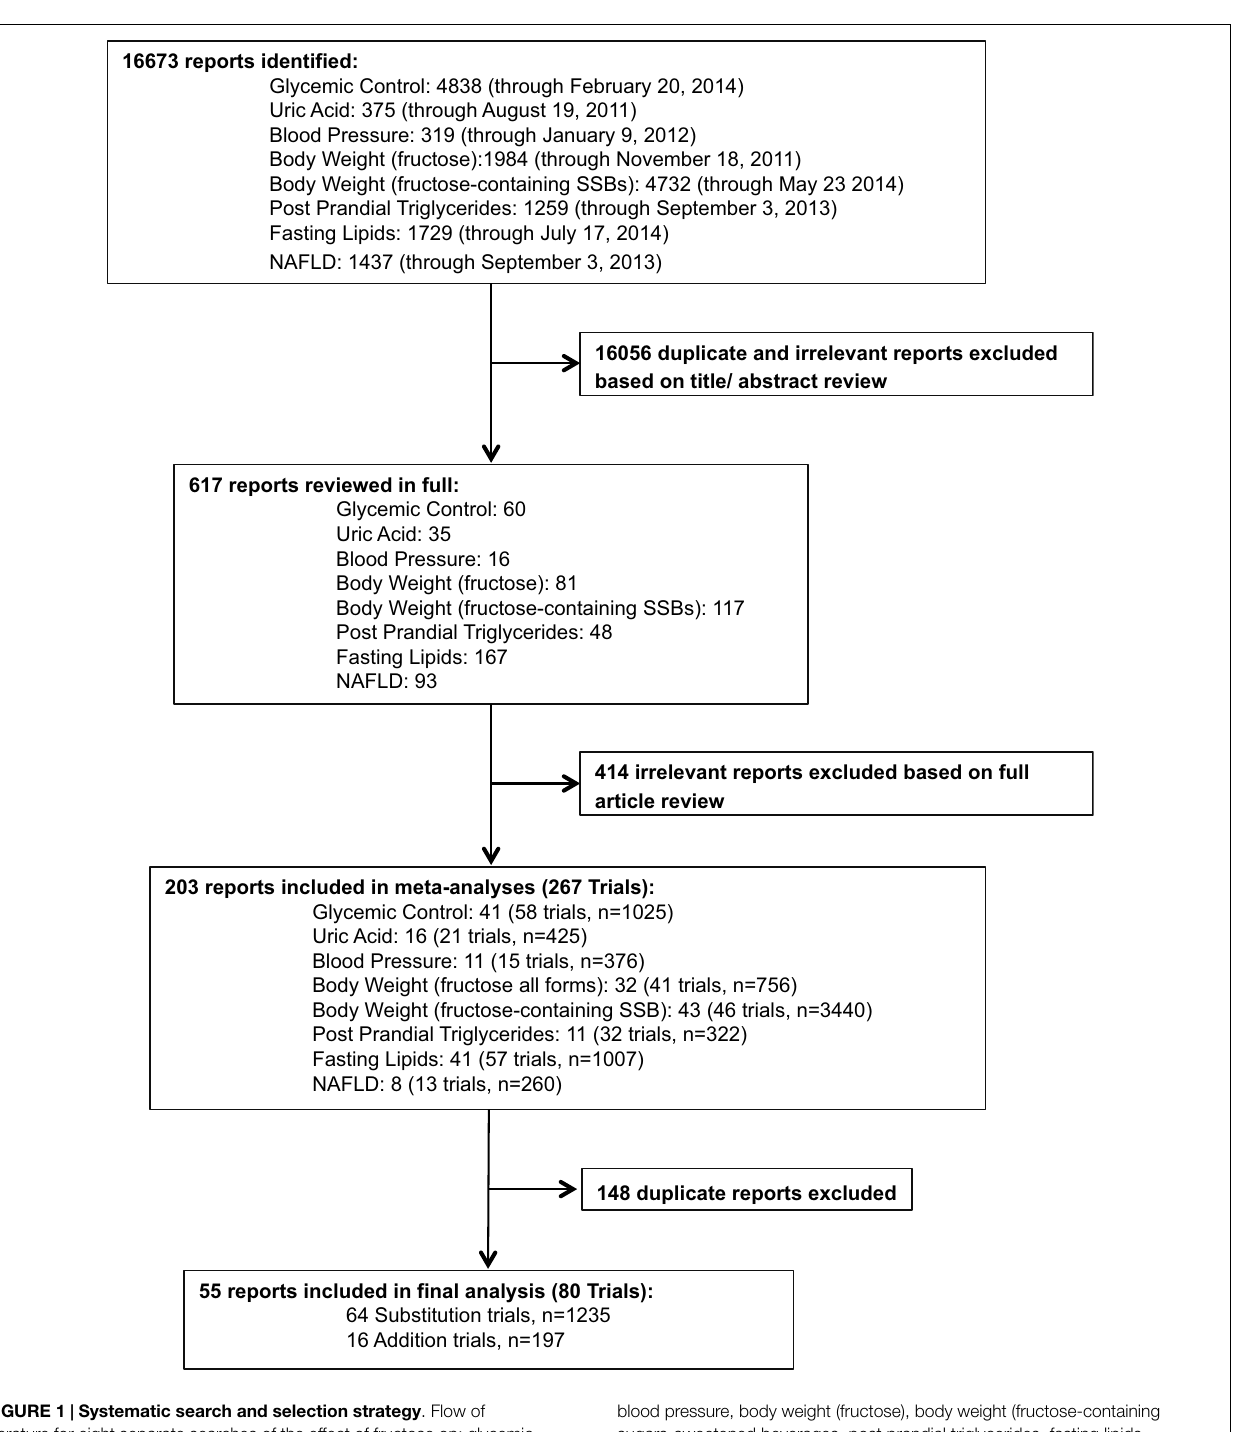
blood pressure, body weight (fructose), body weight (fructose-containing sugars-sweetened beverages, post prandial triglycerides, fasting lipids, and